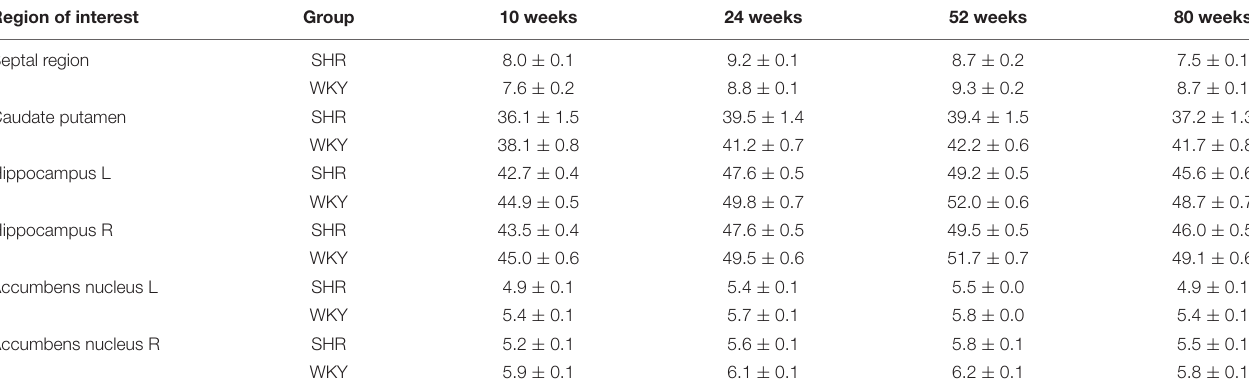
TABLE 3 | Volume (mm 3 ) of selected regions of interest of SHRs and WKY rats at different time points. Region of